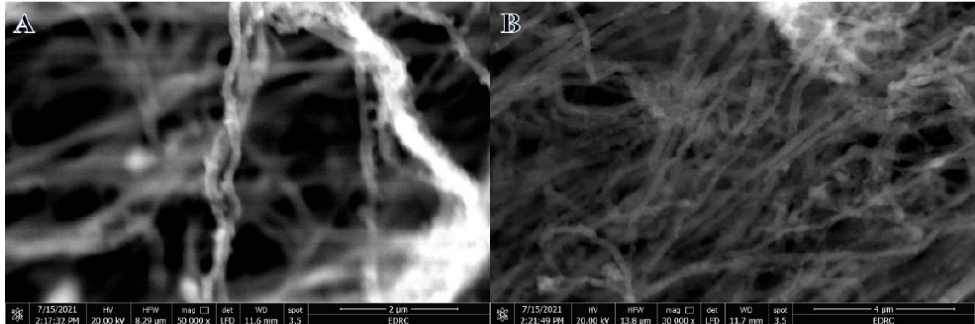
Figure 9. SEM images of the used photocatalyst. ( A ) 50,000 magnification, ( B ) 30,000 magnification.